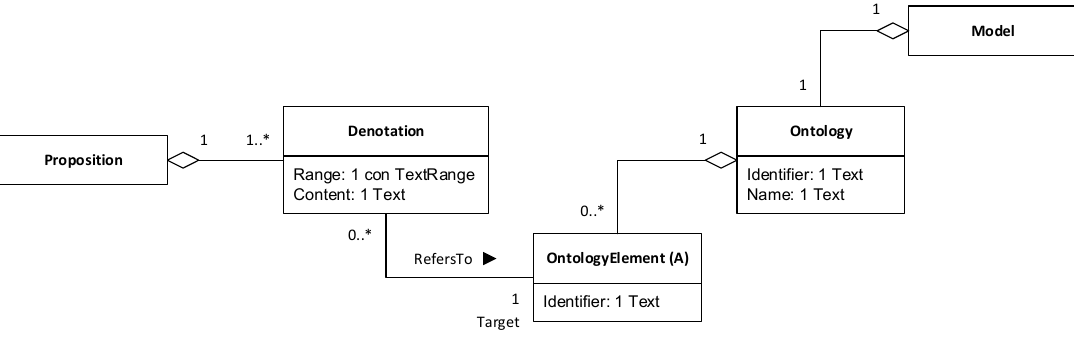
Figure 5. Diagram depicting a section of the IAT + metamodel. Model on the top right refers to discourse models. Ontology refers to domain models (but see text below for details).